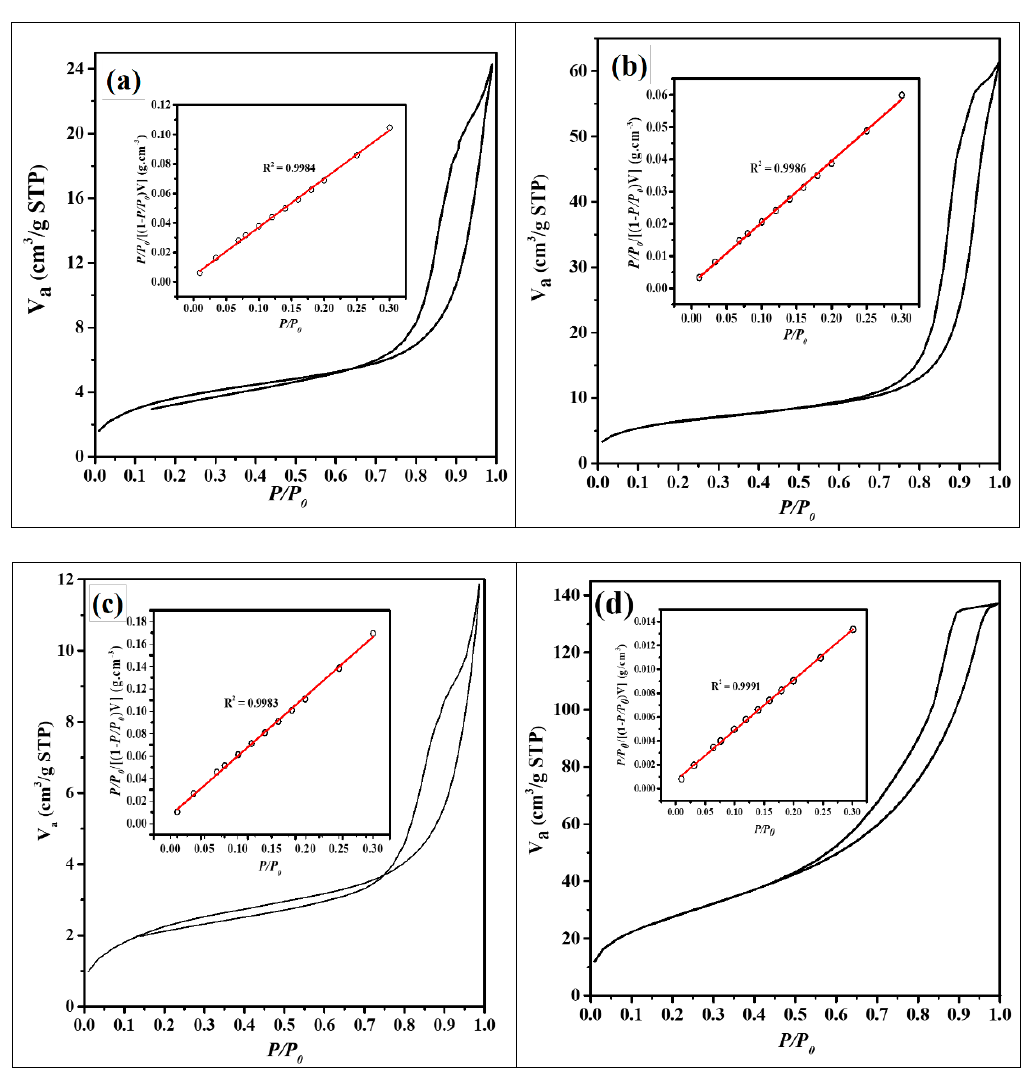
Figure 6. BET nitrogen adsorption–desorption hysteresis curves and linear isotherms (in the inset) of ( a ) Fe 3 O 4 @C-T 190 t 3 ; ( b ) Fe 3 O 4 @C-T 190 t 4 ; ( c ) Fe 3 O 4 @C-T 190 t 5 ; ( d ) Fe 3 O 4 NPs.